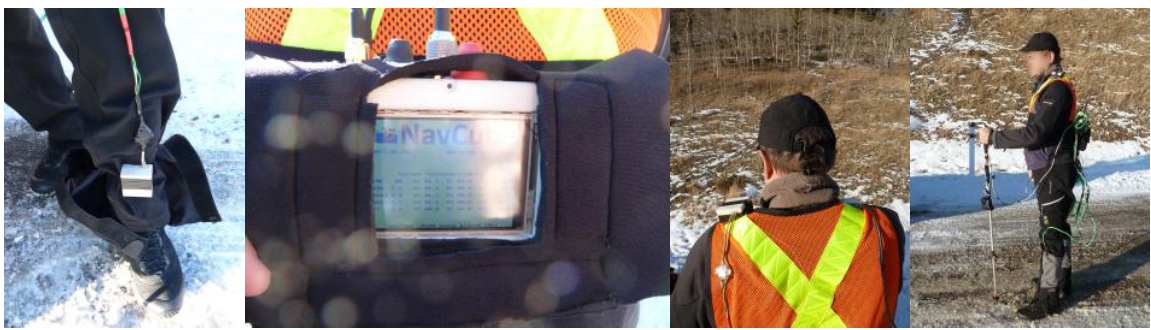
Figure 9. Hiker wearing the NavCube at the waist, two IMUs attached to the leg above the boots, one IMU on the shoulder and a GNSS antenna on the other shoulder.